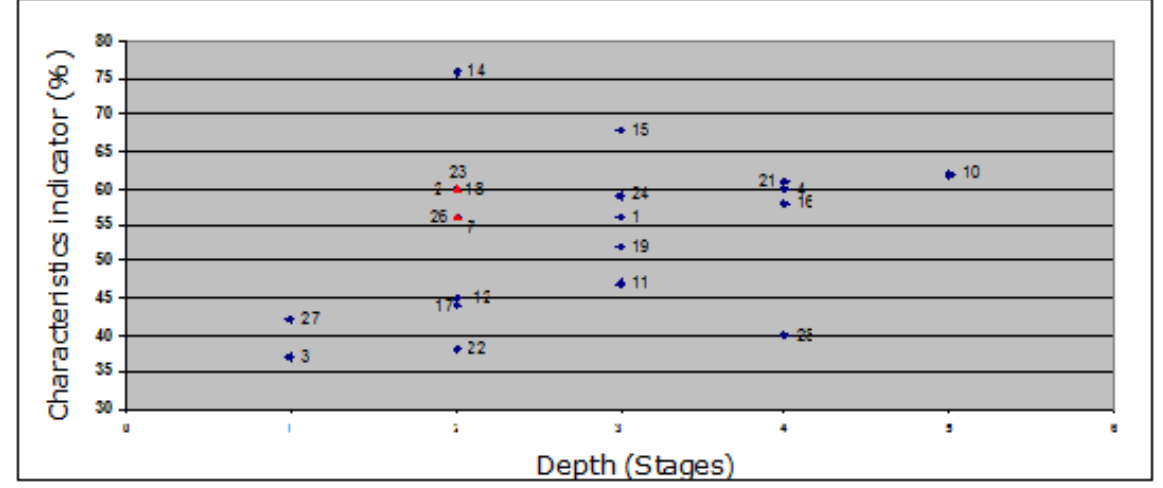
Figure 1. Graph measuring depth and characteristics indicator of analyzed